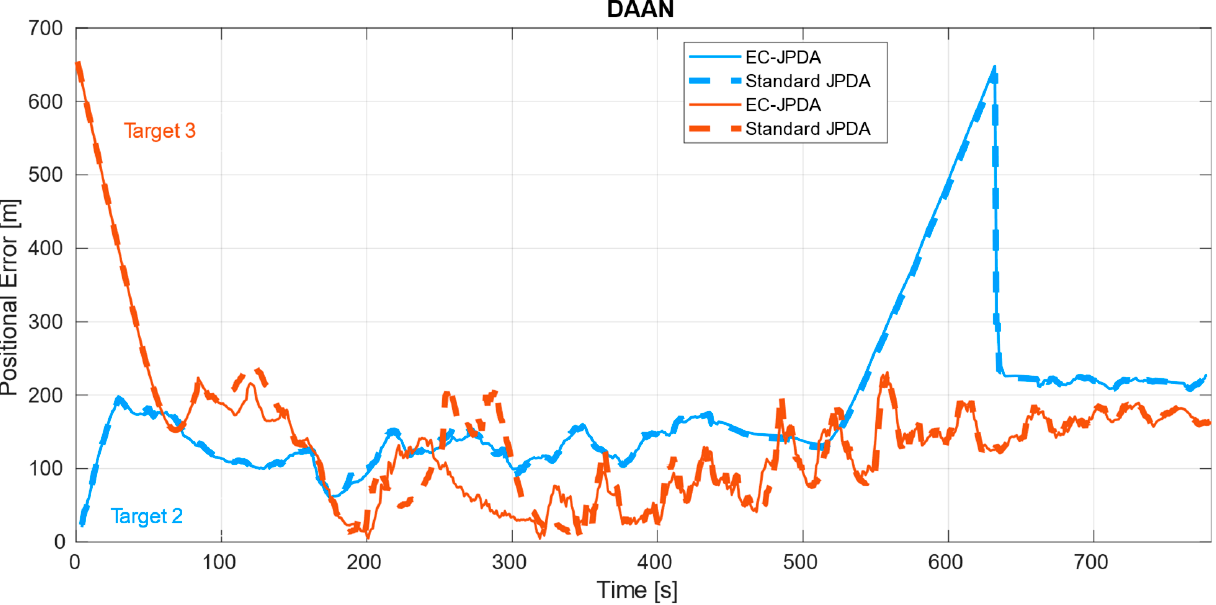
Figure 7. The positional error of the two targets in DAAN.